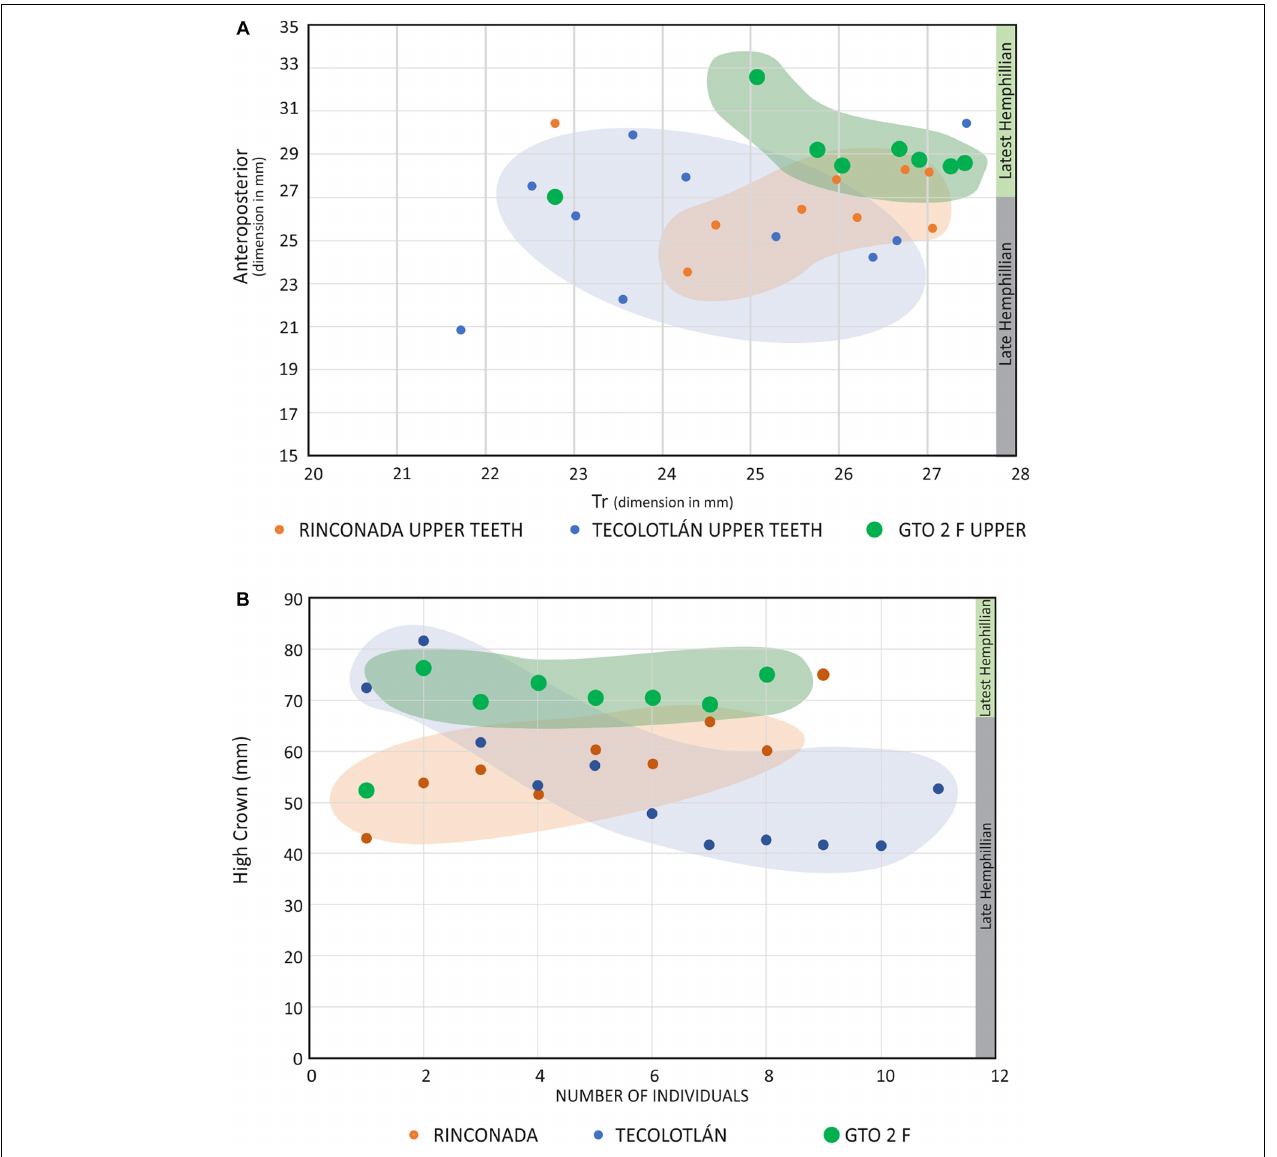
FIGURE 6 | (A) All measurements of the Ap and Tr of M1 in upper molars including those of GTO 2 site F, have been plotted. (B) The measurements of the HC of P4-M1 were also graphed. The separation of GTO 2 F in the two graphs is remarkable, which suggests a different population.